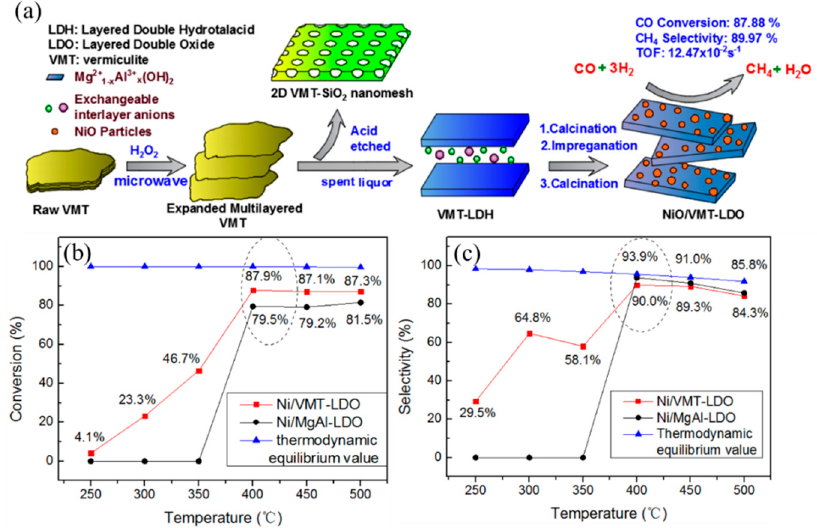
Figure 2. ( a ) Schematic of the preparation process of NiO/VMT-LDO and ( b , c ) the catalytic performance of Ni/VMT-LDO [34]. Table 1. Catalytic performance of CO methanation for different catalysts in different works.